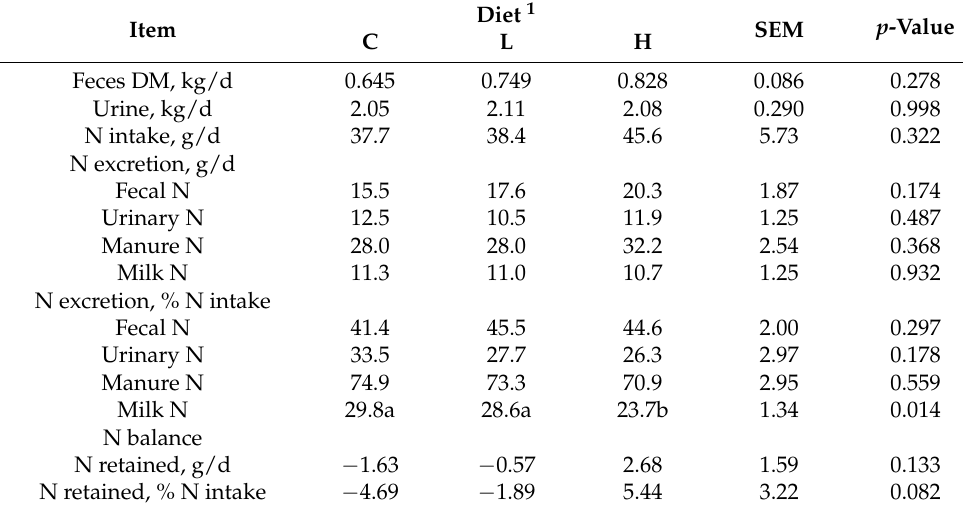
Table 8. Nitrogen balance of the goats fed the experimental